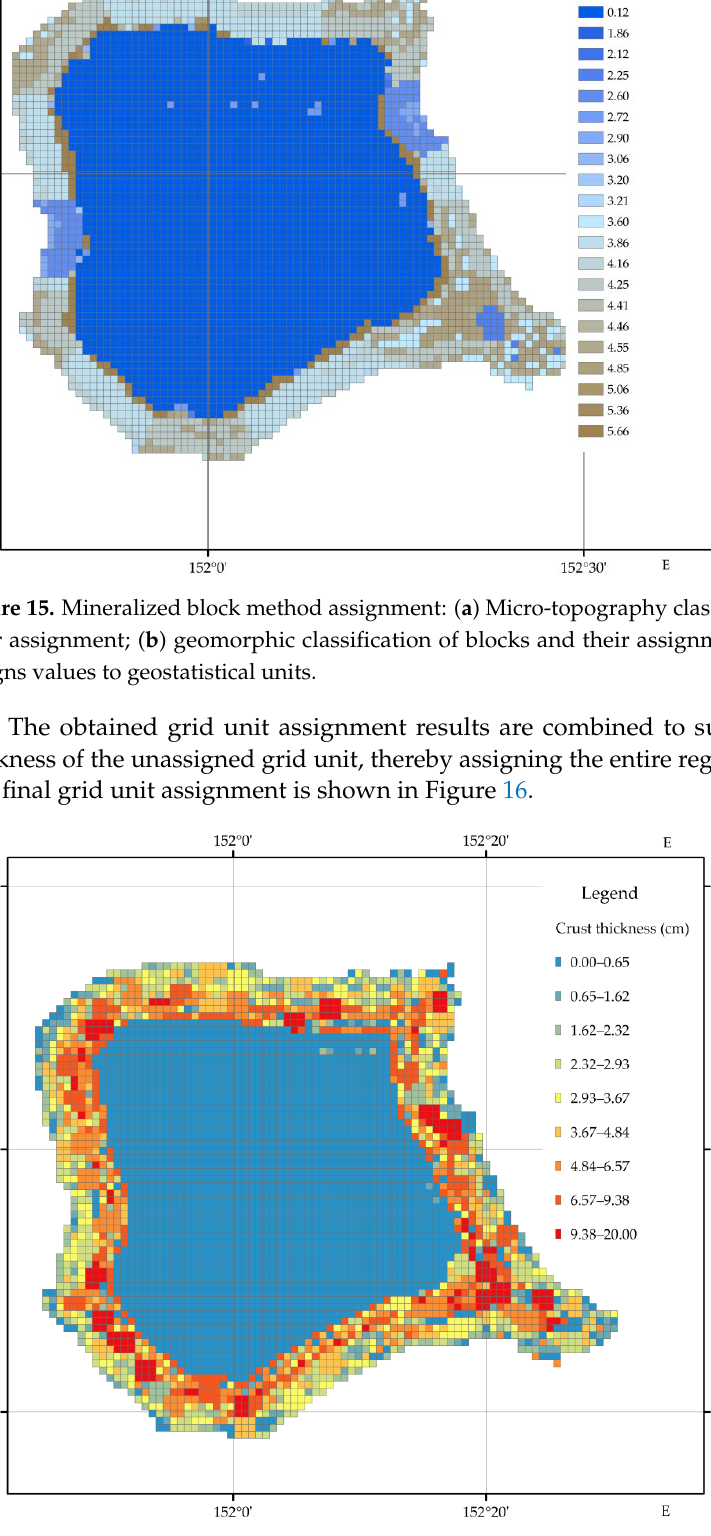
Figure 16. Grid unit assignment of crust